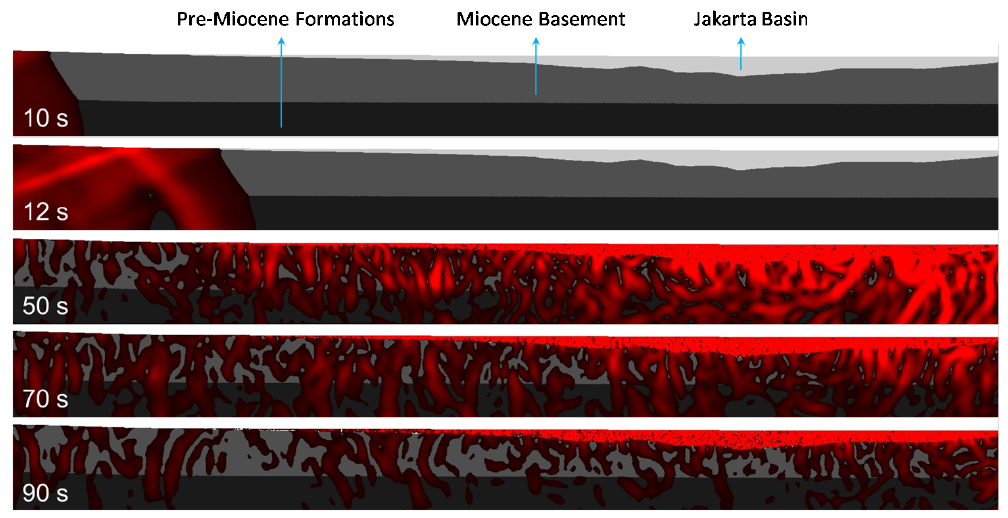
Figure 8. Snapshots of wave propagation, showing waves approaching (10 and 12 s, top two panels) and reverberating inside (50, 70 qnd 90 s, bottom three panels) the basin. The modeled M w 6.5 earthquake is taken to have ruptured a southward dipping, shallow crustal thrust fault 85 km south of the city center. The Jakarta Basin is the light gray colored area, overlying the dark grey medium, clearly shown in the top two pictures capturing snapshots at 10 and 12 s,